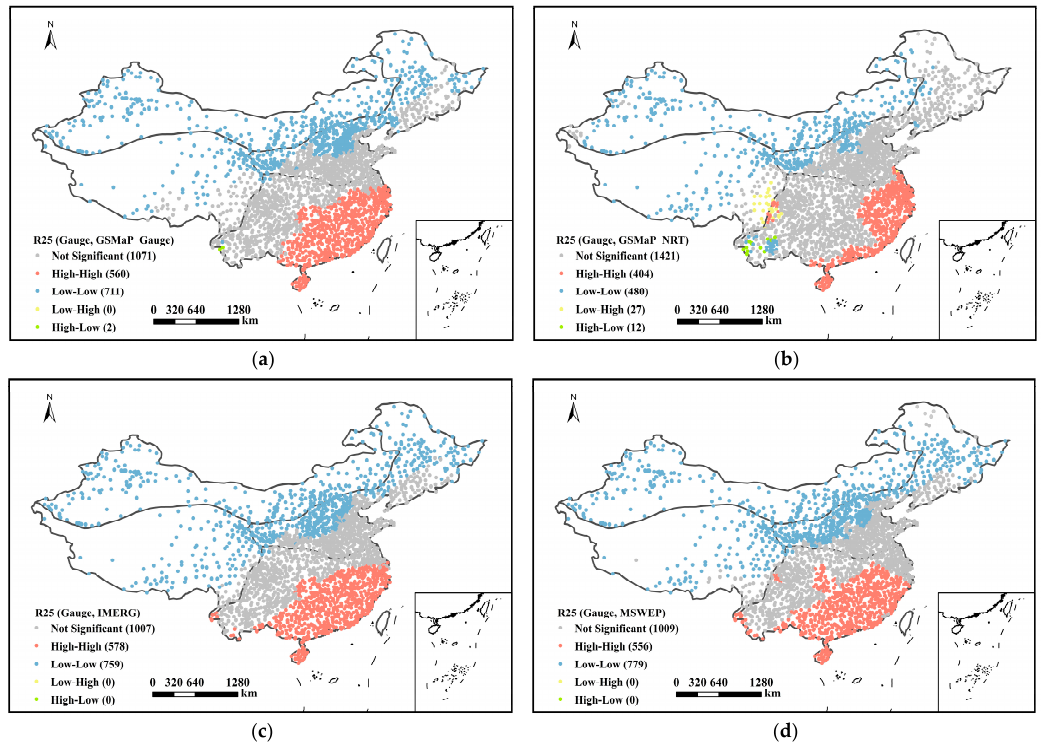
Figure 16. The LISA cluster maps of R25 between the gauge observations and the four SPPs and the number in the bracket represent the corresponding number of gauges: ( a ) GSMaP_Gauge, ( b ) GSMaP_NRT, ( c ) IMERG, and ( d ) MSWEP.